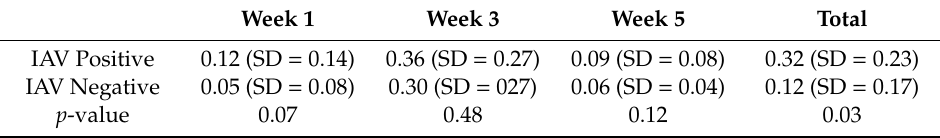
Table 2. Average coughing index (CI) in IAV positive and negative litters/pens.